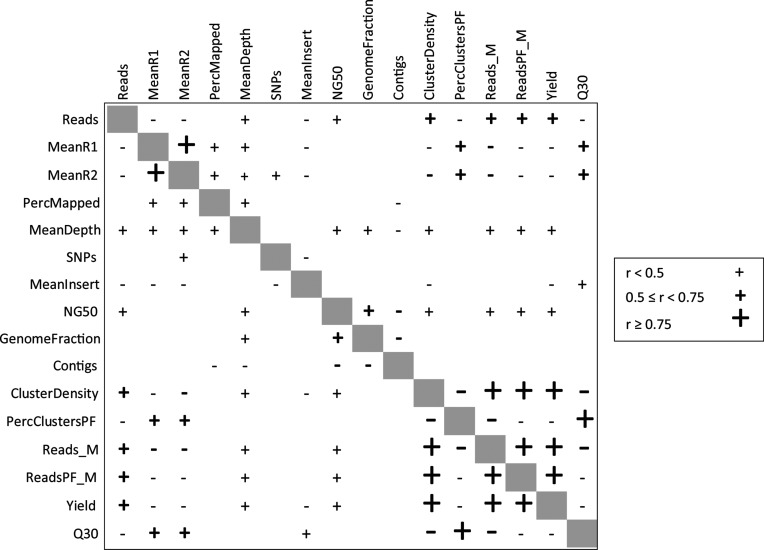
Pearson correlation table of run metrics and summary statistics. Significant positive and negative correlations are represented as + and −, respectively. The size of the symbols and font boldness represent the degree of correlation.